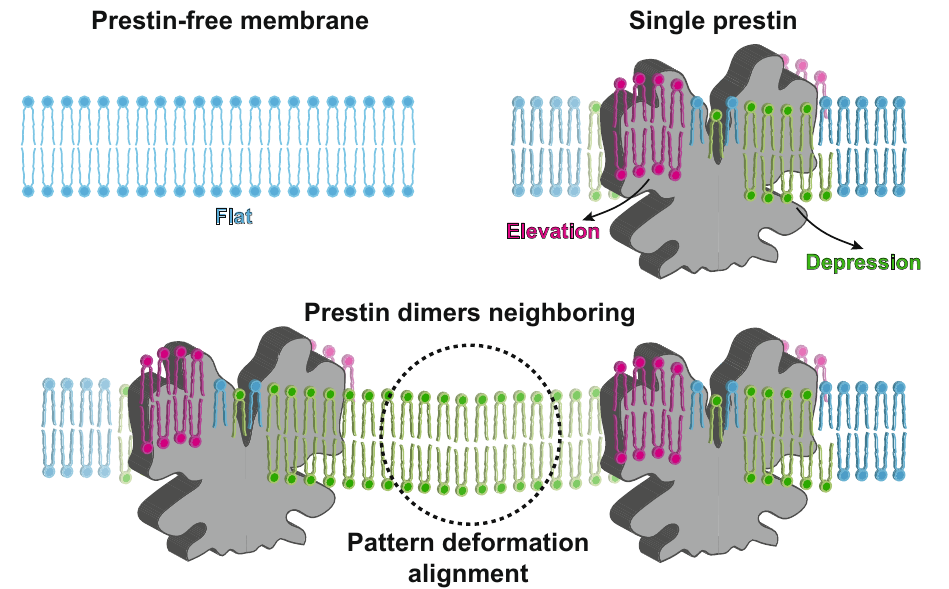
Fig.8|Membranedeformationpatternsinducedbyasingleormultiple-prestin dimers. Aprestin-freemembraneremains fl at,ashighlightedbytheevenheightof its lipids (blue). Prestin deforms the membrane anisotropically by elevating or depressinglipids(magentaandgreen,respectively)initsvicinity.Inamulti-protein arrangement,asintheOHCs,membranedeformationpatternsofindividualprestin